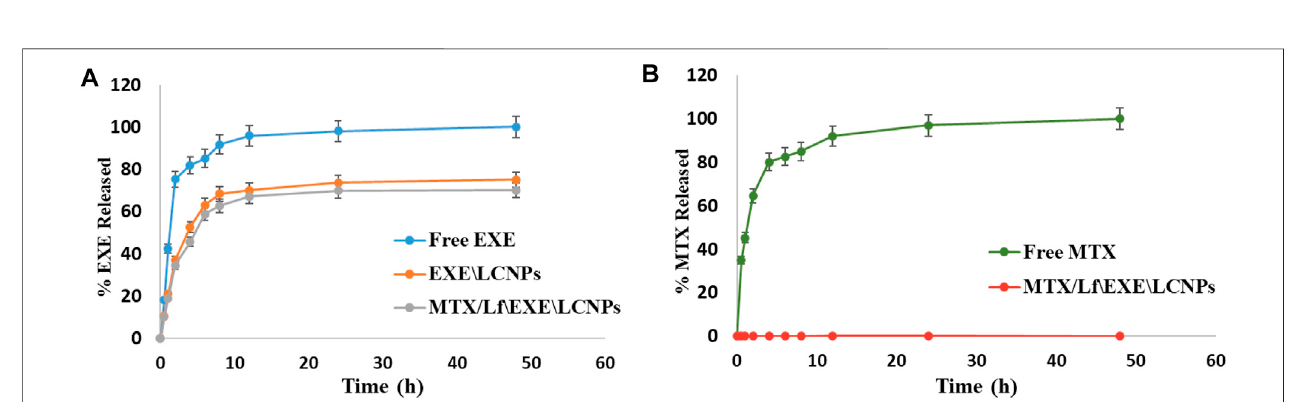
FIGURE 5 | (A) In vitro release study of EXE from free EXE, EXE\LCNPs F2 , and MTX/Lf\EXE\LCNPs F4 at physiological pH 7.4 ( n = 3). (B) In vitro release study of MTX from free MTX and MTX/Lf\EXE\LCNPs F4 at physiological pH 7.4 ( n = 3).